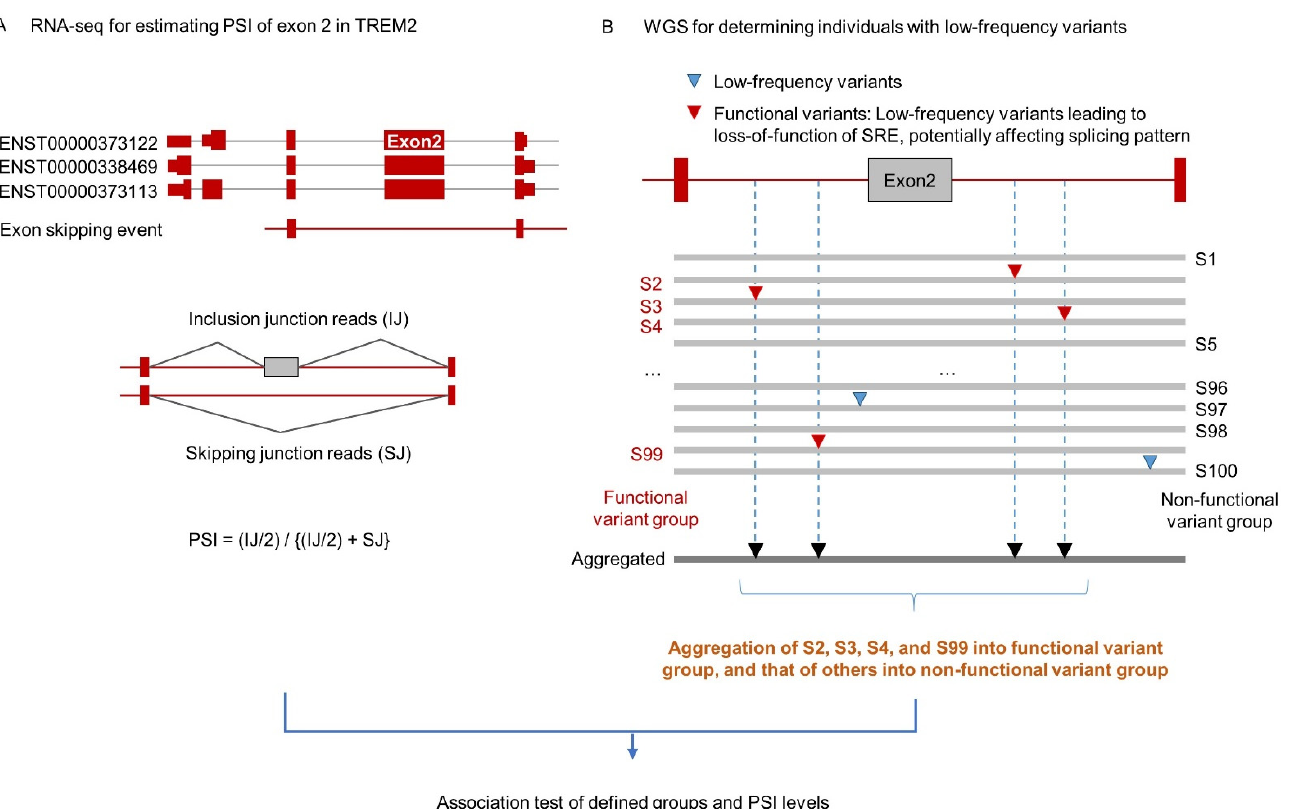
Figure 1. ( A ) The three transcript isoforms of TREM2 , according to annotation of the hg19 reference genome. The rate of exon 2 skipping could be estimated from inclusion and skipping junction reads as PSI. ( B ) Splicing-guided aggregation of rare variants within the TREM2 2nd exon, flanking introns, and neighboring exons. Blue reverse triangles indicate low-frequency variants not leading to SRE loss-of-function; red triangles denote low-frequency functional variants predicted to lead to SRE loss-of-function (see Materials and Methods). Samples with these functional low-frequency variants are aggregated into a functional variant group, while those lacking such variants comprise a non-functional variant group (see Materials and Methods).